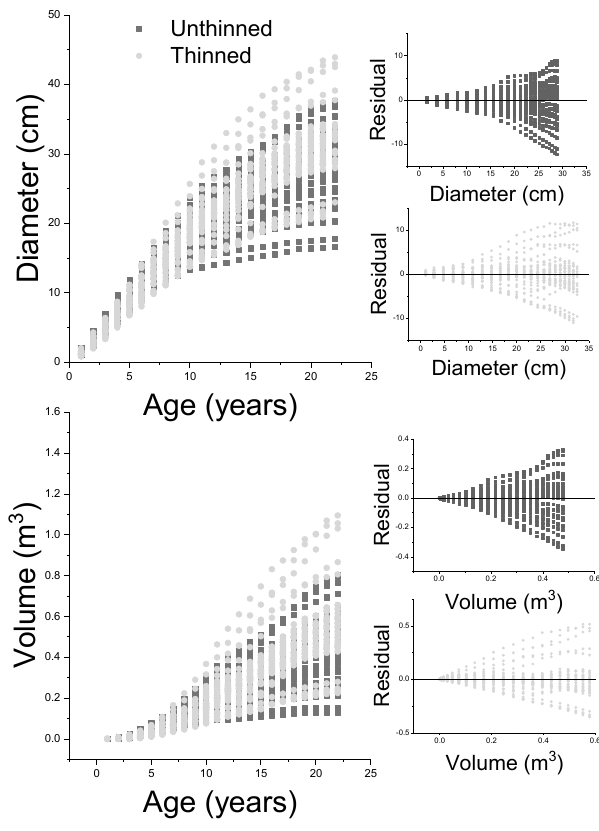
Figure A2. Cumulative DBH and wood volume of unthinned and thinned stands of fitted Equation (2) and their residuals.